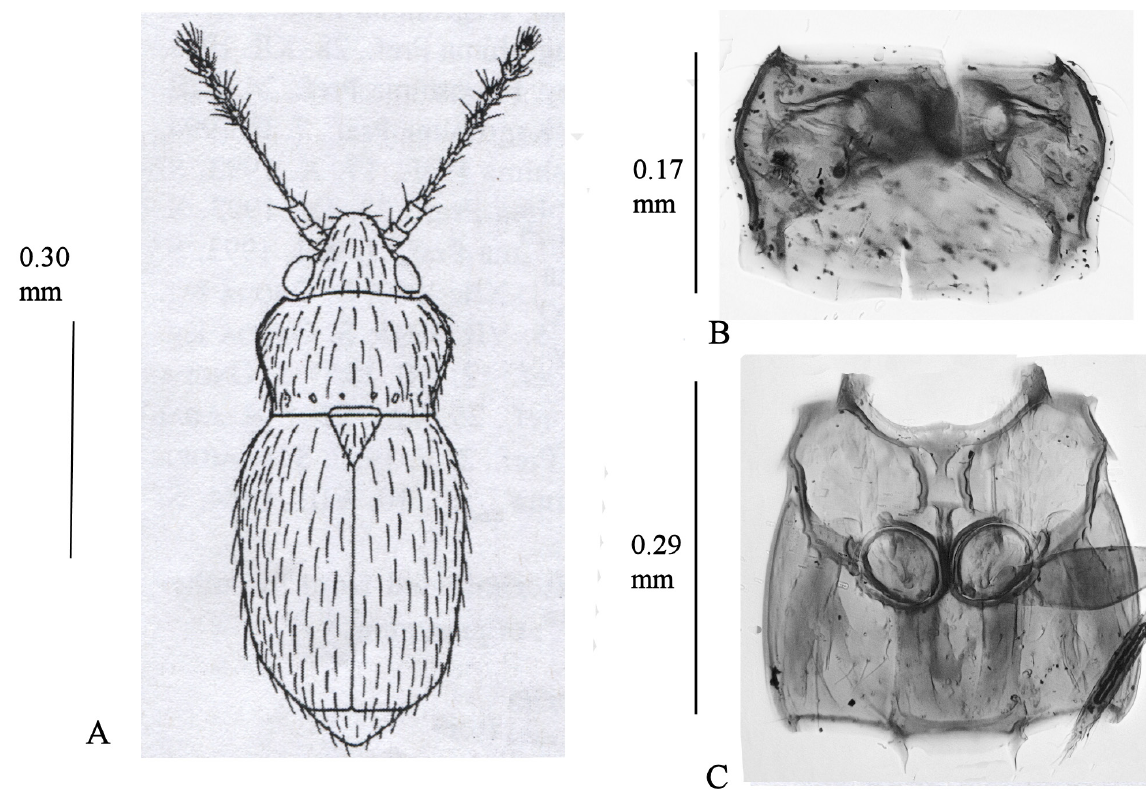
Fig. 29. Cissidium ishigakiense Sawada, 2008. A . Habitus. B . Pronotum from slide preparation. C . Meso- and metaventrite from slide